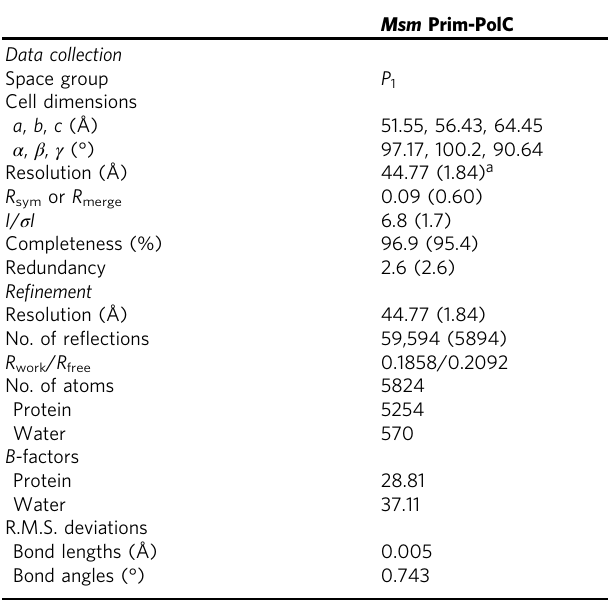
Table 1 Data collection and re fi nement statistics (molecular